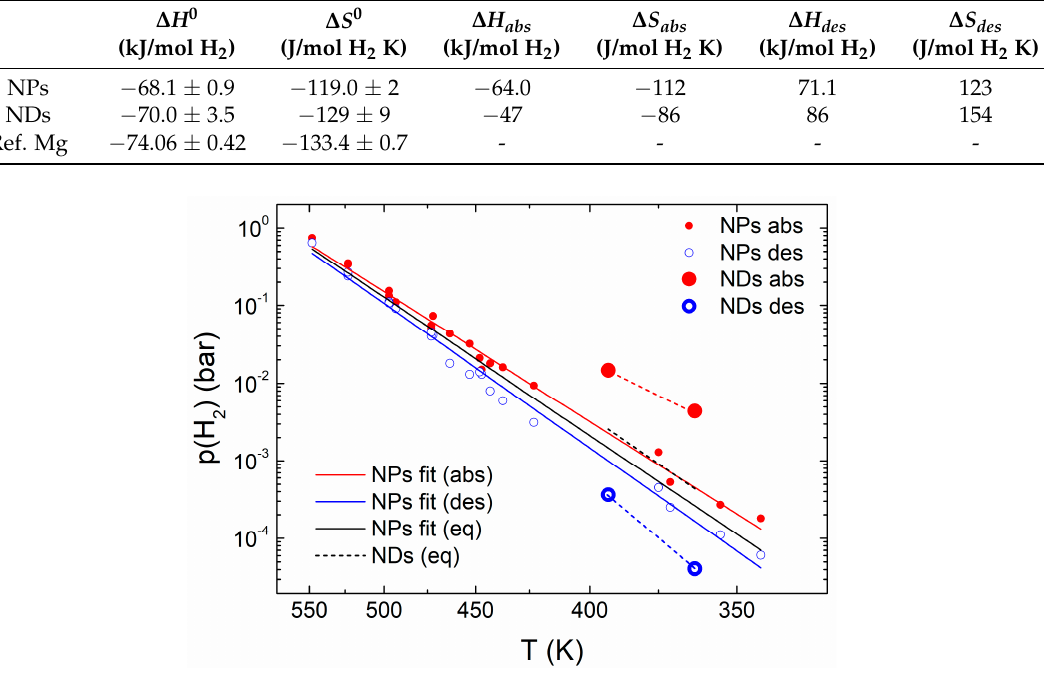
Figure 5. Van’t Hoff plot of sorption (red) and desorption (blue) equilibrium pressures (log scale) versus T (reciprocal scale) measured for NPs samples [8] and NDs ( t = r = 30 nm) [5]. The black solid and dashed lines are the best linear fit on equilibrium pressure values for NPs and NDs respectively. Red and blue solid lines are the best linear fit on absorption and desorption data for NPs.